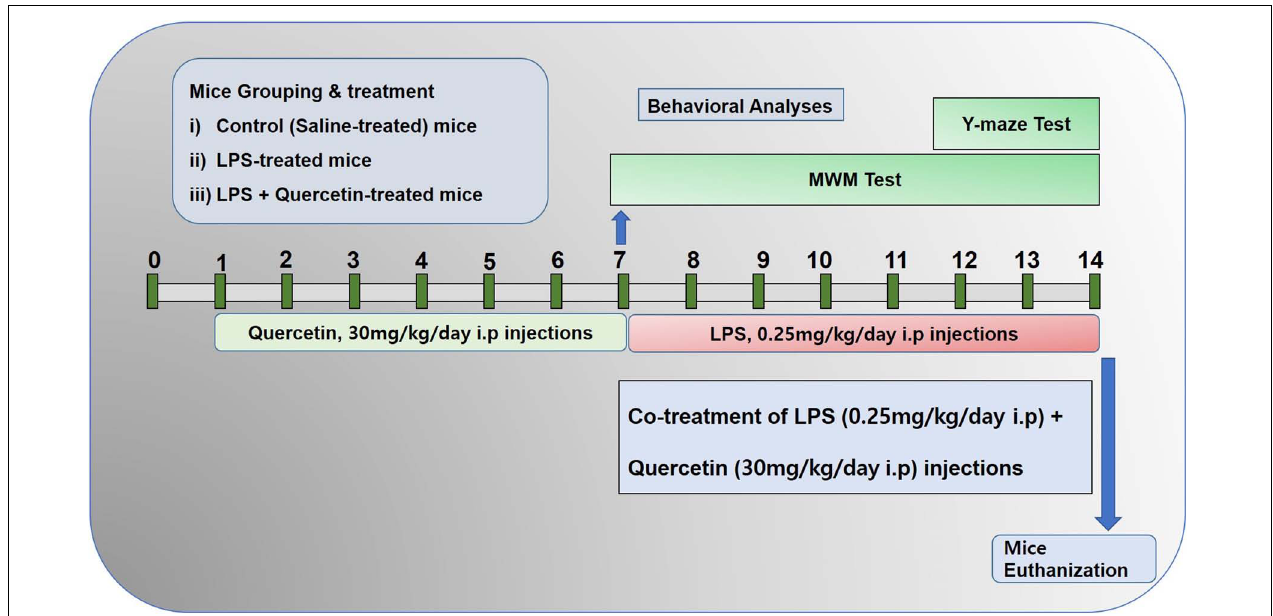
FIGURE 1 | Schematic of the experimental schedule. (1) Control paradigm mice (Cont) treated with saline as vehicle for 2 weeks. (2) Mice treated with vehicle for 1 week and LPS 0.25 mg/kg/day for 1 week. (3) Mice treated with LPS 0.25 mg/kg/day for 1 week and quercetin 30 mg/kg/day for 2 weeks (1 week before the LPS and 1 week cotreated with LPS). After behavioral analyses on the 14th day, the adult mice were euthanized and further subjected to western blotting and morphological